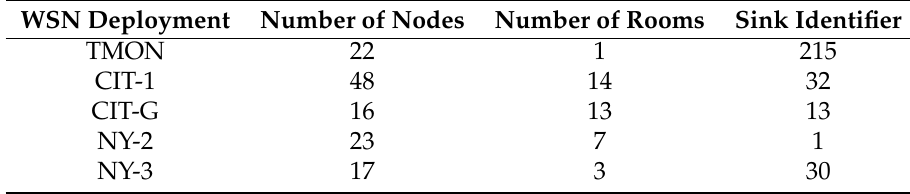
Table 5. WSN deployment information.